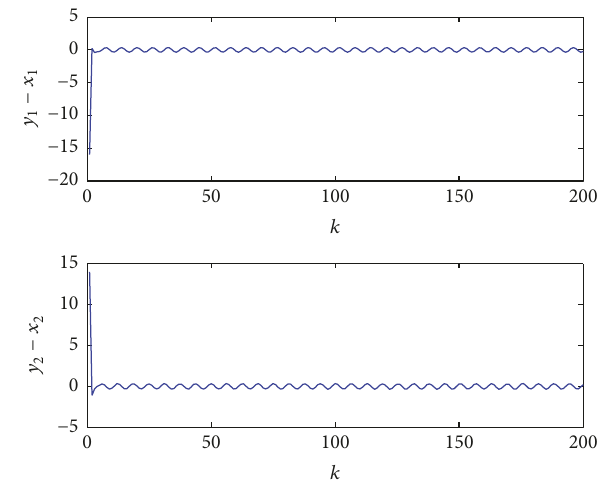
Figure 2: Synchronization errors between the uncertain distur- bance H´enon maps.